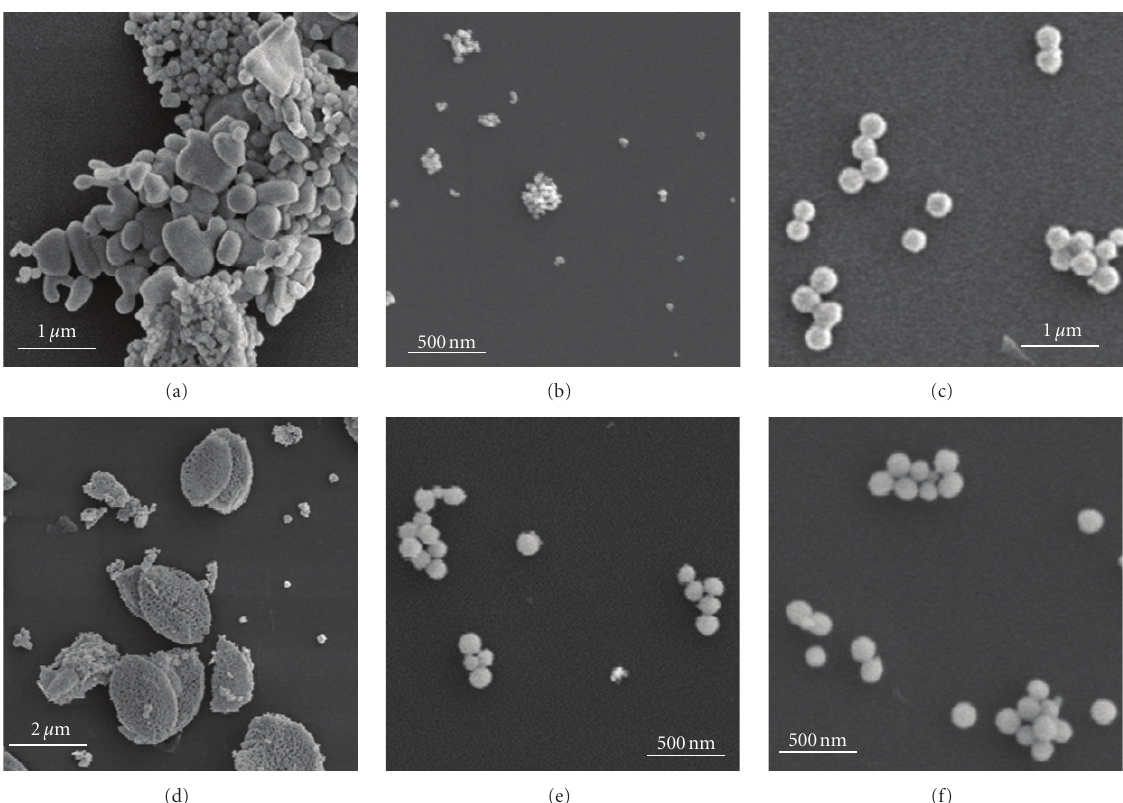
Figure 2: Scanning electron micrographs of Gd 2 O 3 :Er 3+ ,Yb 3+ particles obtained by precipitation methods: (a) ParticlesAP , (b) ParticlesEP , (c) ParticlesHP , (d) FlakesHP , (e) ParticlesHP-PEG and (f) ParticlesHP-CTAB